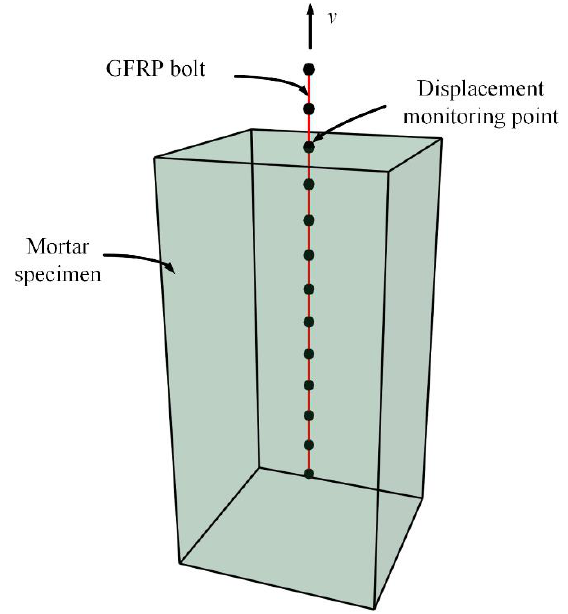
Figure 8. Numerical model of pull-out test on GFRP bolts.